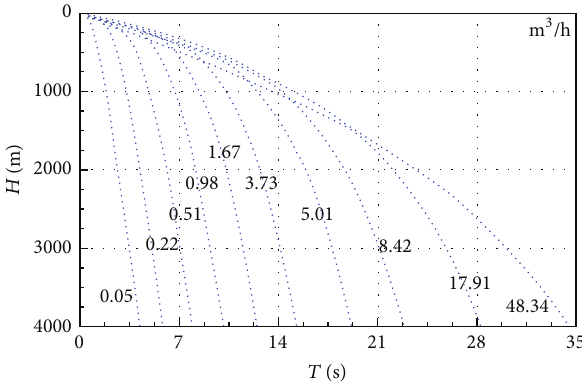
Figure 8: Effect of gas influx rate on the wave velocity. Figure 9: Effect of gas influx rate on the pressure response